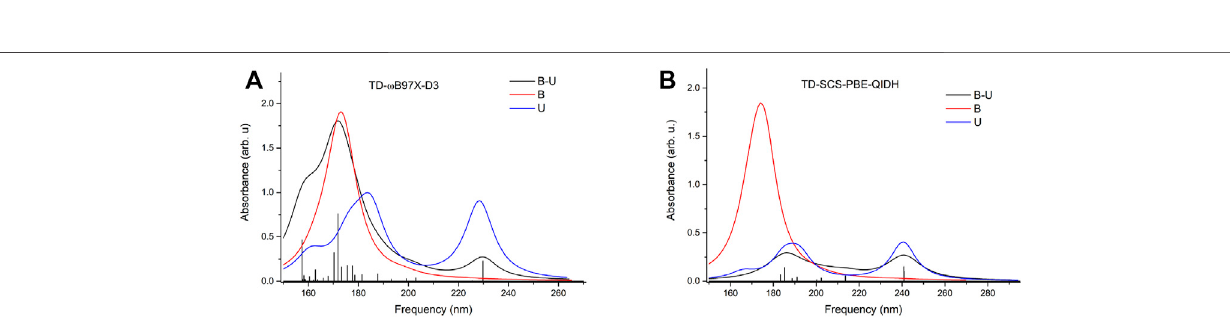
FIGURE 2 | (A) The equilibrium geometry of the cyclic adduct and (B) the transition state geometry between benzene and uracil units in the benzene – uracil (B – U) complex.